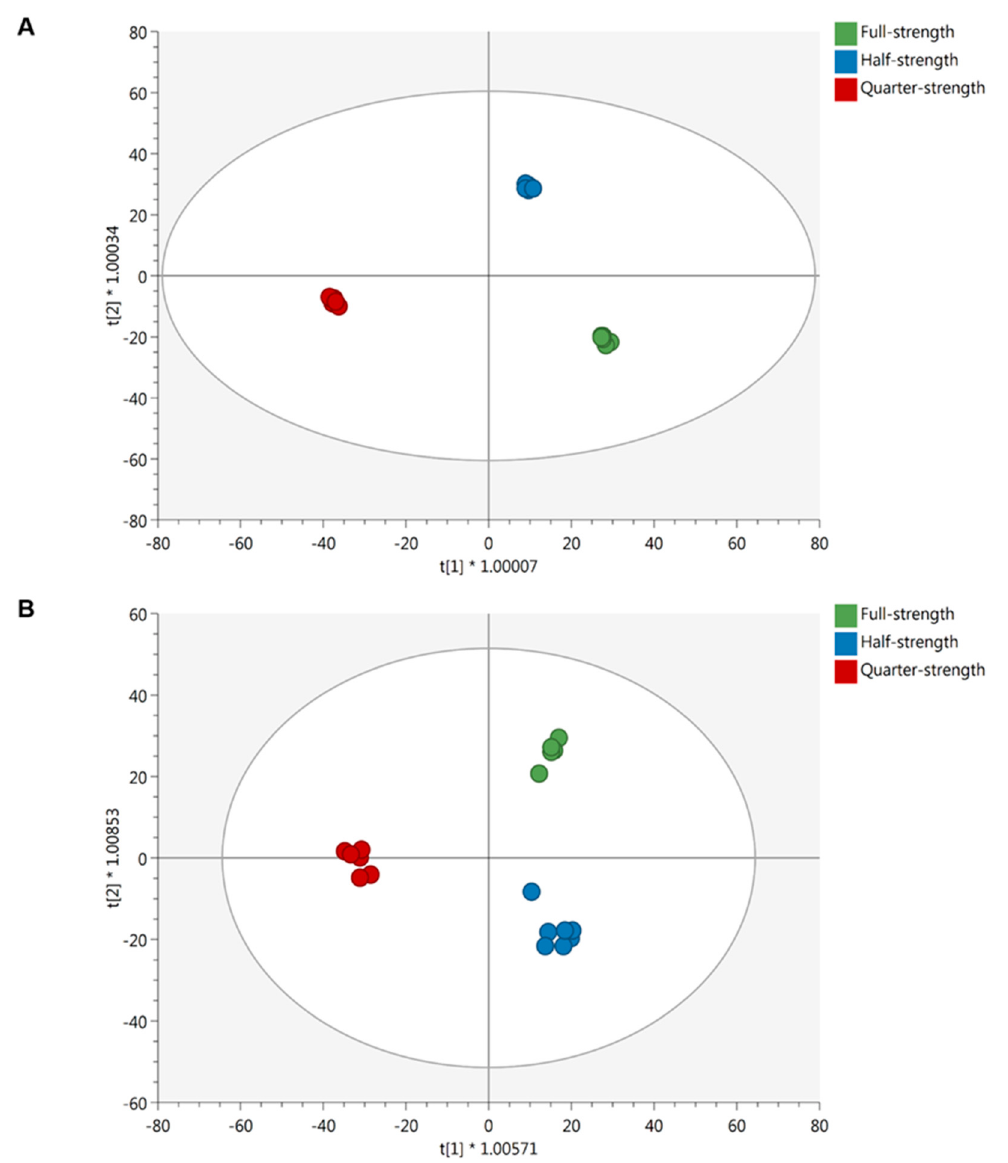
Figure 1. Score plot of orthogonal projection to latent structures discriminant analysis (OPLS-DA) supervised modeling carried out on untargeted metabolomics profiles of ‘Red’ ( A ) (R 2 Y = 0.99, Q 2 Y = 0.91) and ‘Green Salanova’ ( B ) (R 2 Y = 0.97, Q 2 Y = 0.69) subjected to different nutrient solutions.